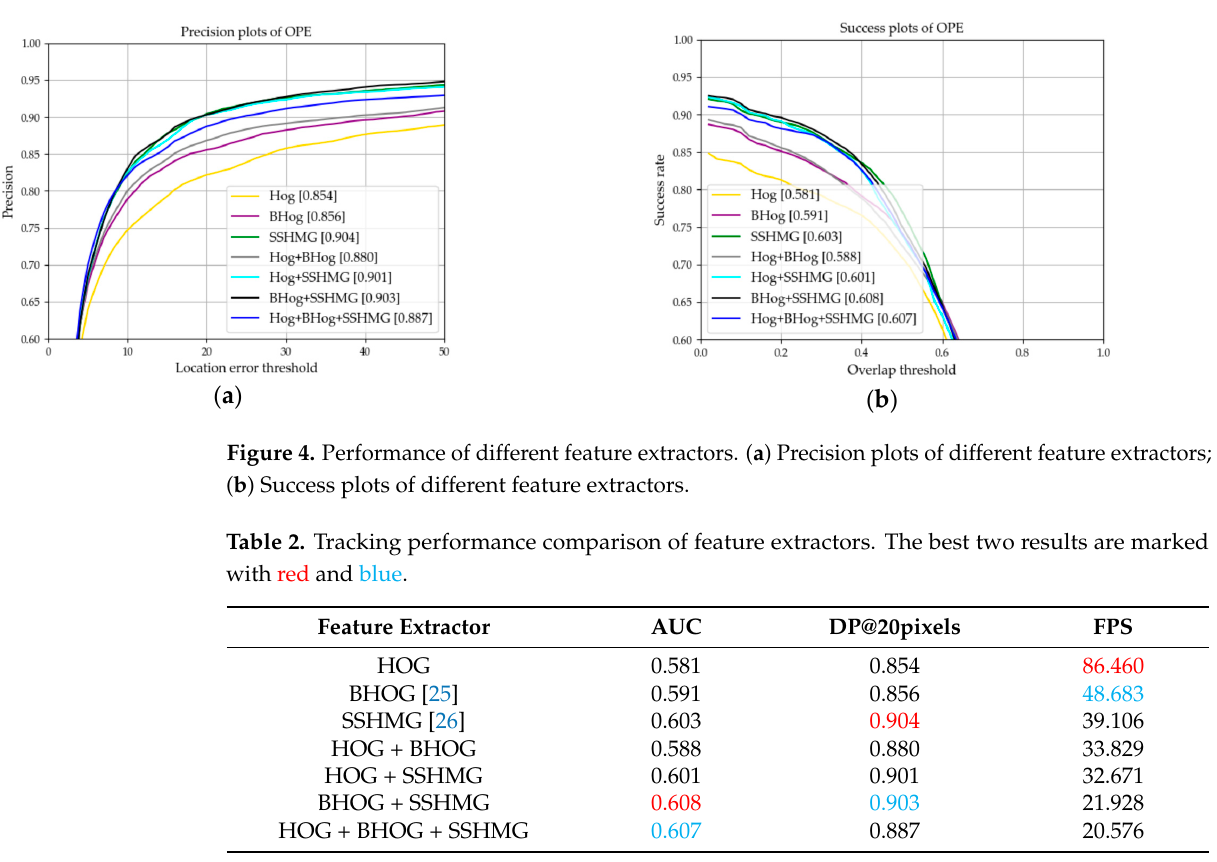
Table 2. Tracking performance comparison of feature extractors. The best two results are marked with red and blue.